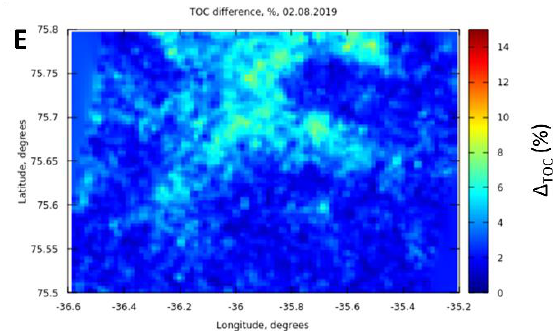
Figure 9. The retrieved snow parameters in the vicinity of the EGP site (75.6247N, 35.9748W) on the 2 August 2019: EGD ( A ), SSA ( B ) and BBA ( C ), as well as the retrieval quality metrics: sRMSD rel ( N = 16), the per-pixel relative spectral RMSD between observed and retrieved TOA reflectance ( D ) and Δ TOC , the per-pixel relative difference between the retrieved total ozone column and the value from ECMWF provided with the OLCI files ( E ).